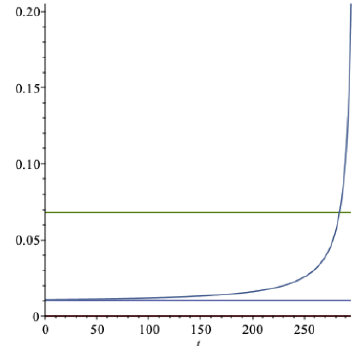
Figure 5. Optimal spending rate vs. expected return; γ > ρ